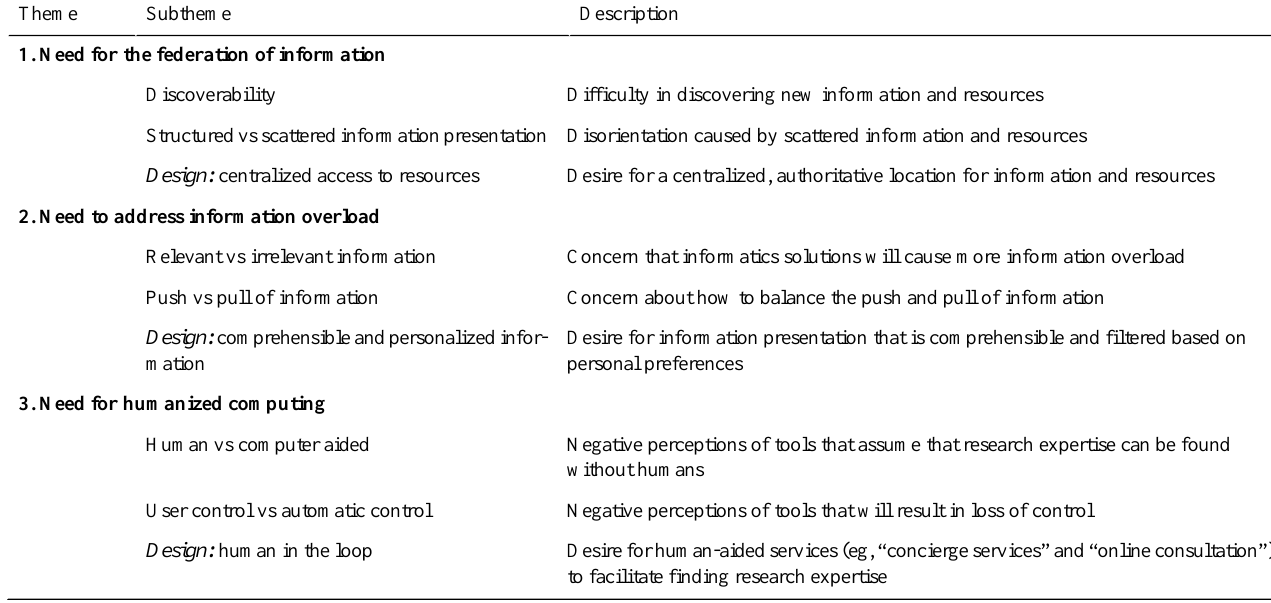
Table 2. Themes of user needs and design suggestions identified through the qualitative analysis of the interview